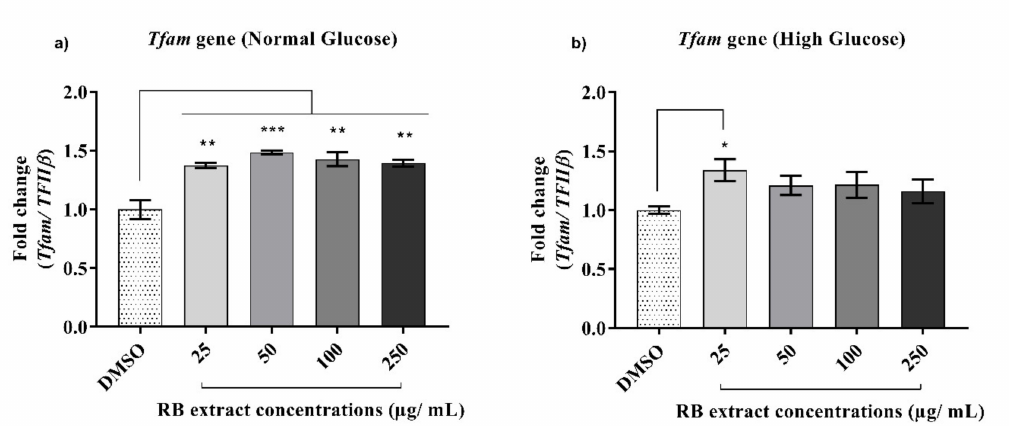
Figure 5. E ff ect of RB phenolic extracts on the expression of the Tfam gene under normal and high glucose conditions in INS-1E cells. ( a ) Normal glucose conditions, ( b ) High glucose conditions ( n = 5). The level of significance is indicated by the asterisks, whereby * p < 0.05, ** p < 0.01, *** p < 0.001. Data are presented as Mean ± SD. Dimethyl sulfoxide, DMSO; Insulin-secreting rat insulinoma cell, INS-1E; Mitochondrial transcription factor A, Tfam ; Rice bran,